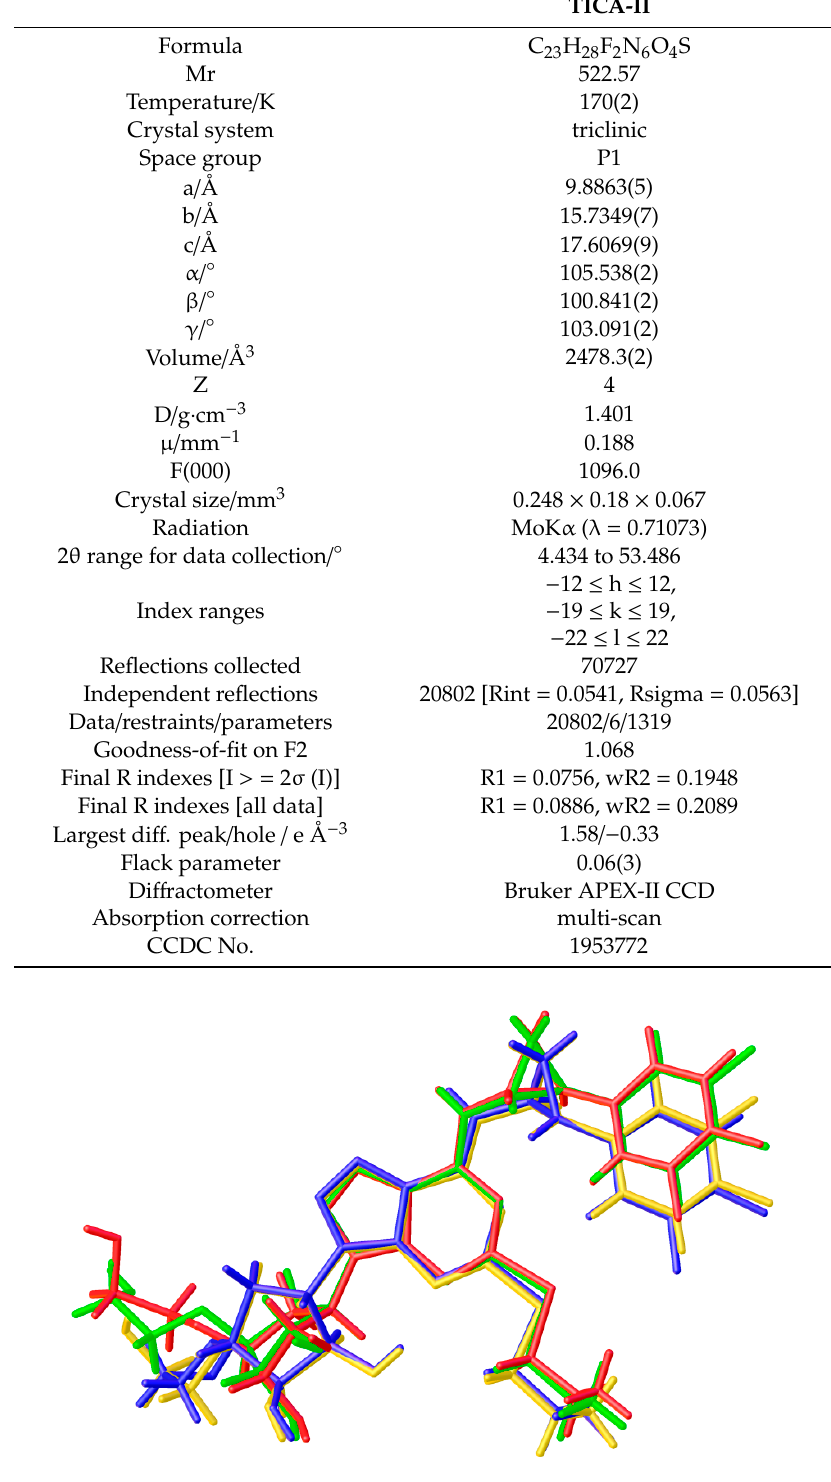
Figure 2. Overlay diagram for superposition of independent molecules of TICA-II crystals.